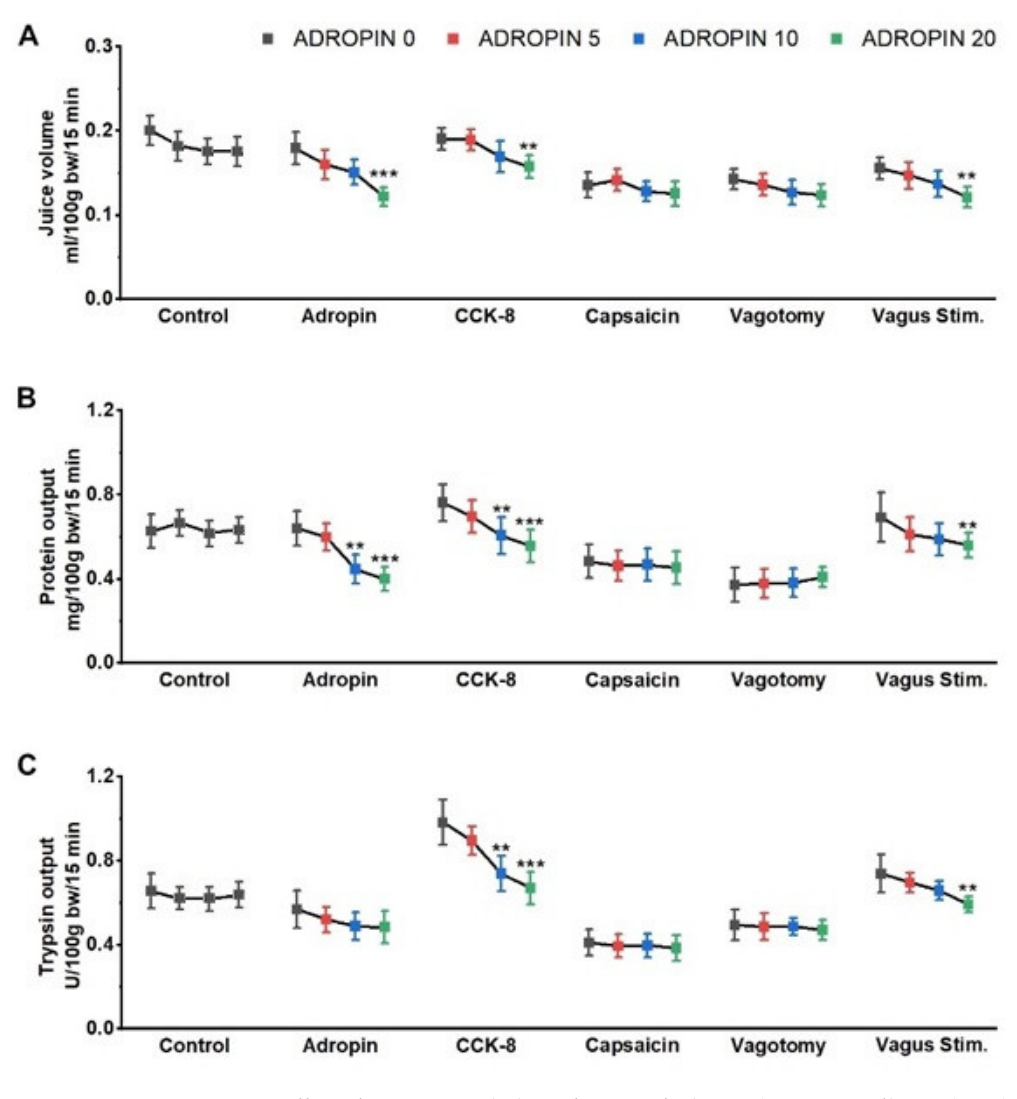
Figure 3. Effect of intravenous bolus infusions of adropin (5, 10, 20 µg/kg BW) on ( A ) the pancreaticobiliary juice (PBJ) volume, ( B ) protein output, and ( C ) trypsin output in control, basal (vehicle), CCK-8-stimulated (12 pmol /kg BW/ h), and basal secretion following vagotomy, capsaicin pretreatment in anesthetized rats. Each bar represents a 15 min PBJ sample after infusion of the vehicle alone or adropin. Each bar represents the mean ± SD (n = 6) of three independent experiments. Data were analyzed using one-way repeated measures ANOVA followed by Dunnet as post-test: ** p < 0.01, *** p < 0.001 vs. Adropin 0 (vehicle bolus, Phase 1).